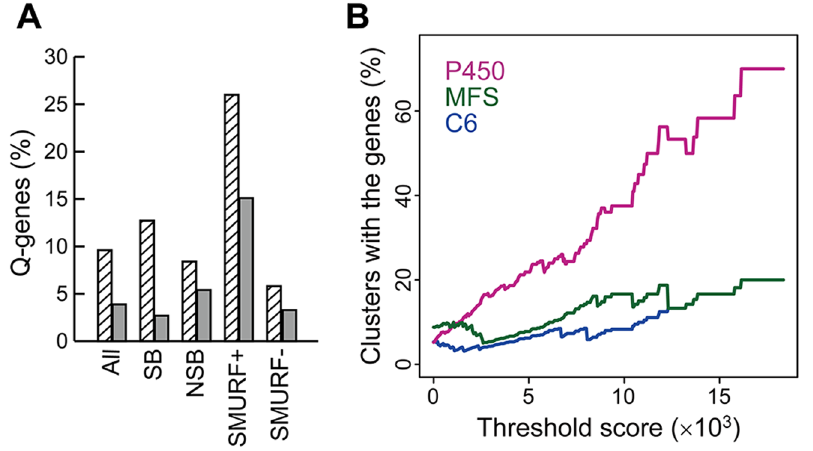
Figure 5. Frequency of SMB-related genes in clusters detected by MIDDAS-M. (A) Ratios of SMB-related genes (Q-genes) detected by KOG analysis with the cluster genes detected by MIDDAS-M (hatched bars) and all the genes in the corresponding genome (gray bars). (B) The proportion of clusters containing genes annotated as P450 enzymes (pink), C6 transcription factors (blue), and major facilitator superfamily members (green) were calculated for detected clusters with the threshold score of v max in A. flavus . The value is plotted to a v max of 18,350, at which 10 clusters remain to be detected.